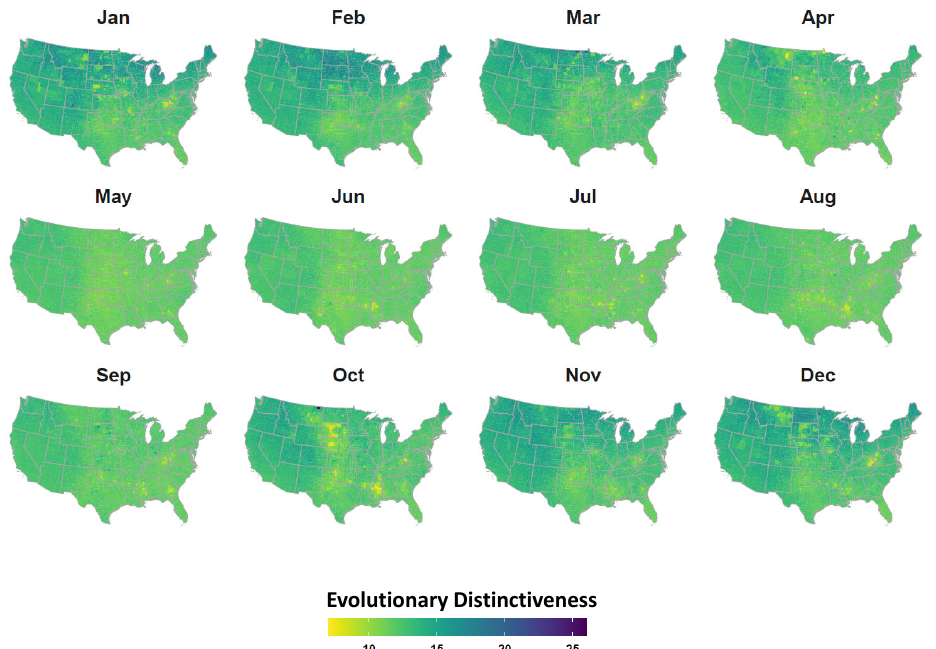
Figure A10. Dynamic avian evolutionary distinctiveness. Evolutionary distinctiveness covariate under assumption of a dynamic species pool (monthly varying). Covariate reflects degree of species isolation on the phylogeny or the average distance of a species to all other species in the community. Mapped counties are color coded according to legend at bottom to indicate increased evolutionary distinctiveness with darker tones.